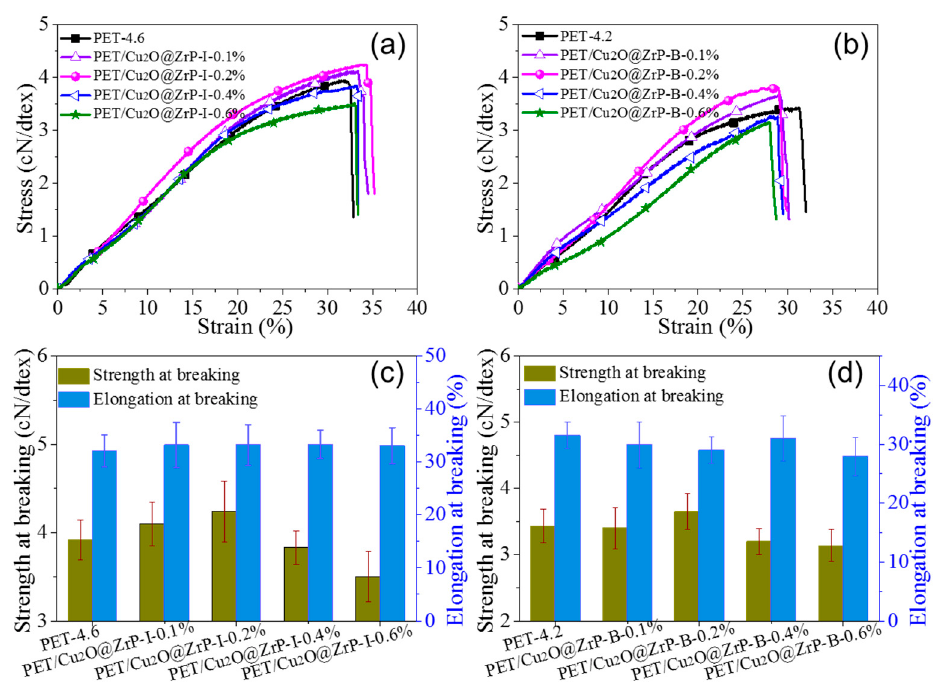
Figure 4. ( a , b ) Stress-strain curves and ( c , d ) mechanical performance of neat PET, PET/Cu 2 O@ZrP-I and PET/Cu 2 O@ZrP-B fibers, respectively.